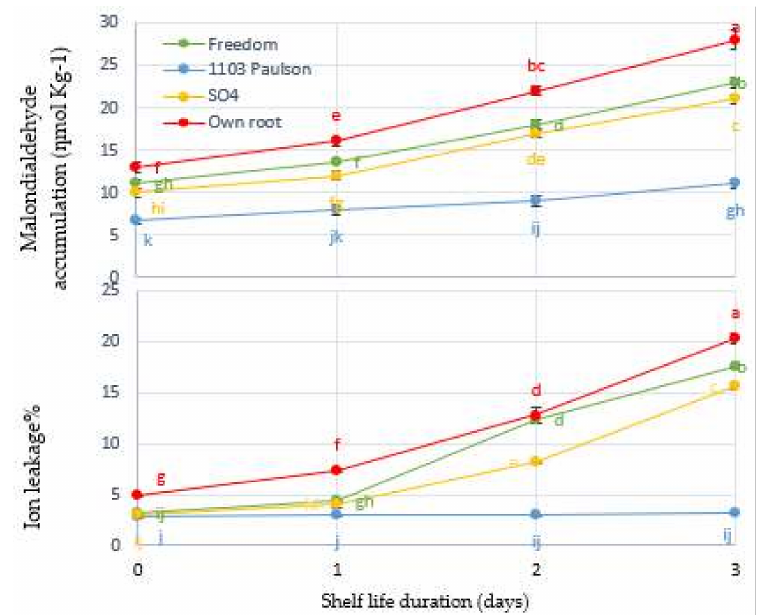
Figure 6. Interaction between Superior Seedless grapevine rootstocks (Freedom, 1103 Paulsen, SO 4 , and Own Root) and shelf life in days and the effect on malondialdehyde (MDA) and ion leakage % during three days of shelf life (27 ± 1 ◦ C with 57 ± 3% RH). Significantly different samples, according to Tukey’s HSD test at 5%, are indicated by different